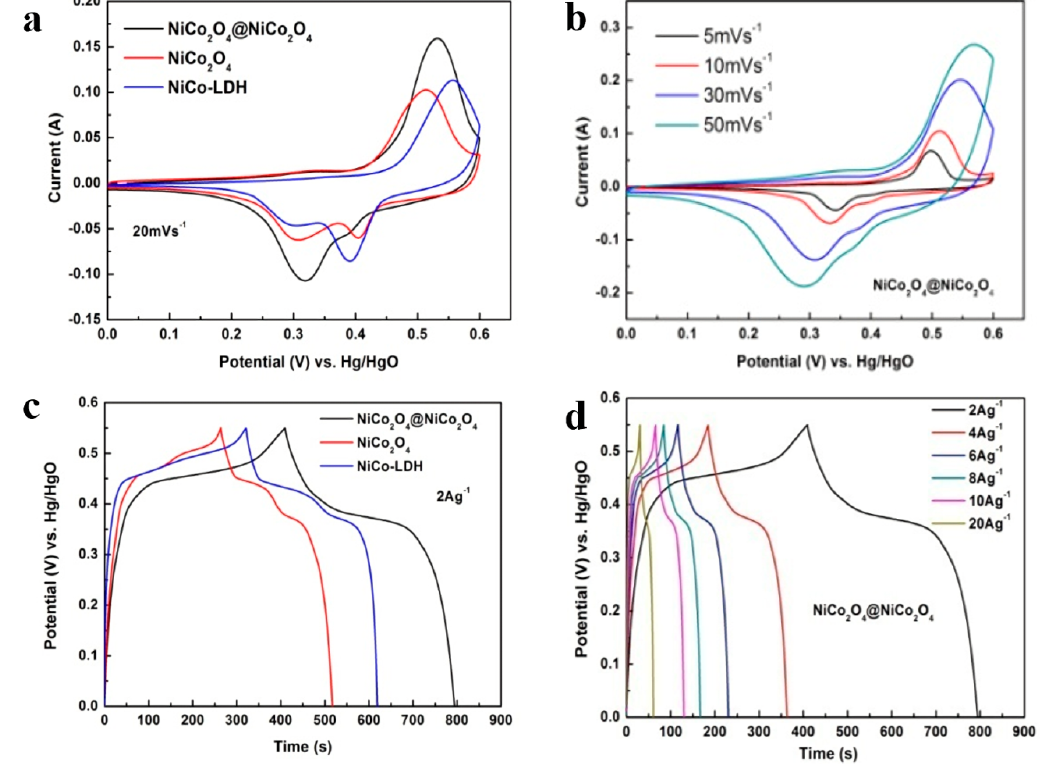
Figure 5. Cyclic voltammetry (CV) plots of ( a ) the NiCo 2 O 4 @NiCo 2 O 4 nanoflake array, bare NiCo 2 O 4 nanoflake, and NiCo-LDH samples at 20 mV s − 1 scanning rate. ( b ) CV plots of the NiCo 2 O 4 @NiCo 2 O 4 sample at various scan rates. Charge discharge (CD) plots of ( c ) the three samples at 2 A g − 1 current density and ( d ) NiCo 2 O 4 @NiCo 2 O 4 at various CDs.